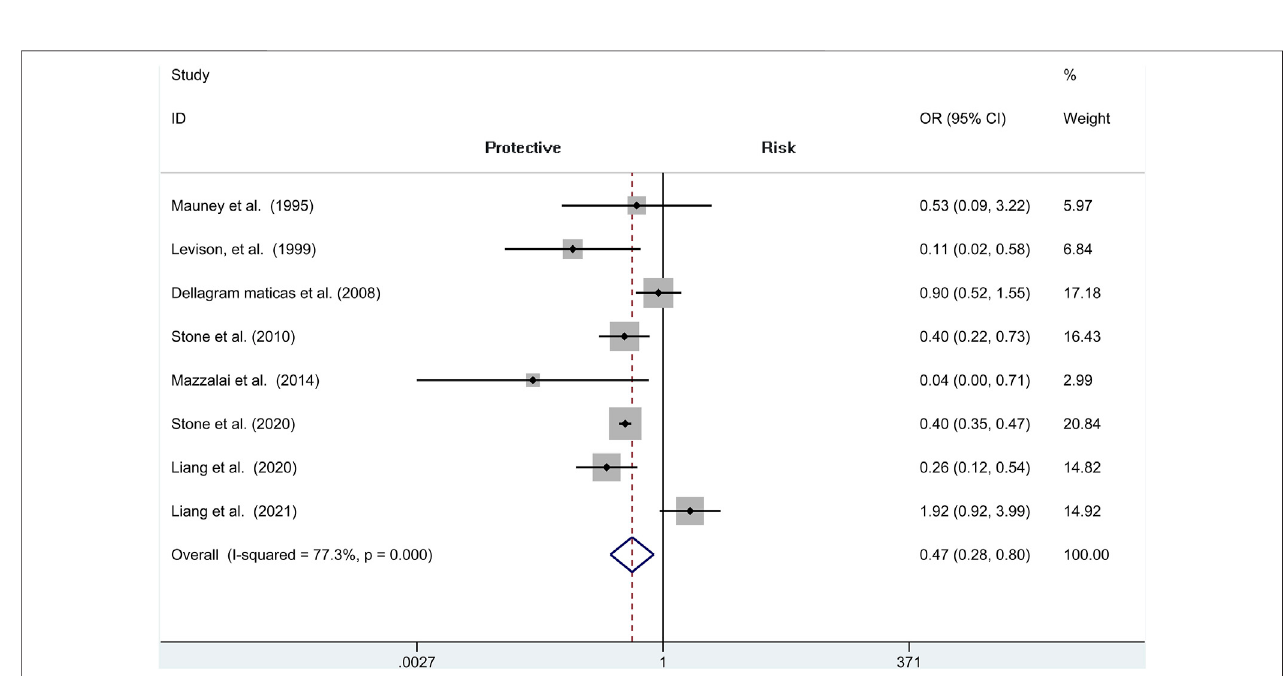
FIGURE 3 | Forest plot for meta-analysis of the incidence of hematoma requiring re-operation.